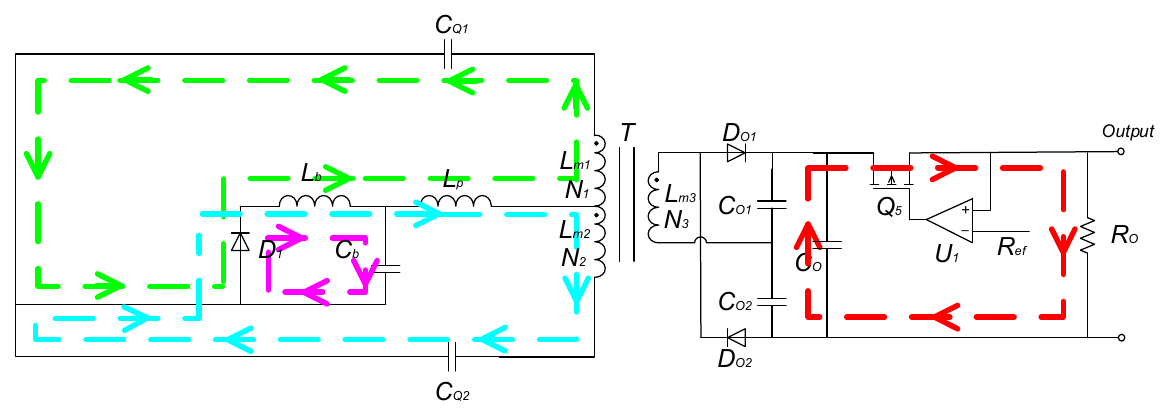
Figure 4. The equivalent circuit diagram when Q 1 and Q 2 are both turned off. Since there is no energy exchange between the primary side and the secondary side, the voltage across C b can be considered constant, with the equivalent circuit of Figure 4 depicted in Figure 5.